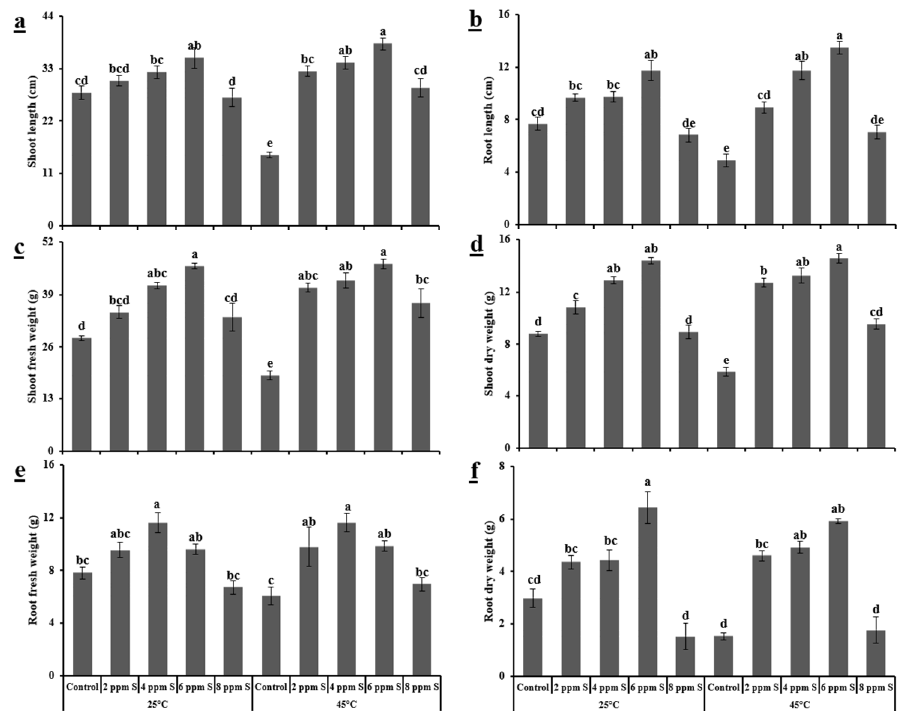
Figure 1. Morphological variables [i.e., shoot length ( a ), root length ( b ), shoot fresh weight ( c ), shoot dry weight ( d ), root fresh weight ( e ), root dry weight ( f )] of tomato plants (cv. Roma) as affected by temperature and exogenous application of S. Same letters indicate non-significant differences among treatments according to Tukey’s honestly significant difference test ( p ≤ 0.05). Vertical bars indicate averages ± standard errors ( n = 4, 5 plants per replicate).